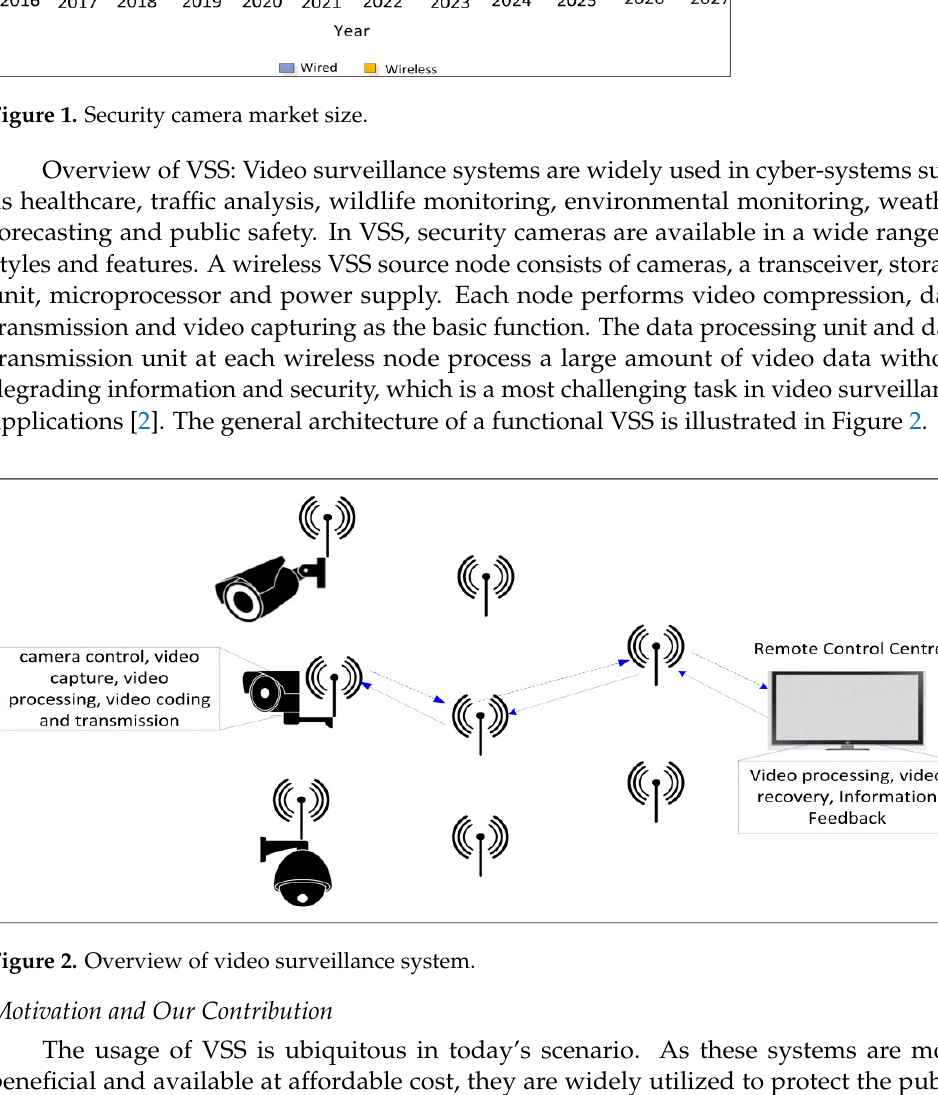
Figure 2. Overview of video surveillance system.